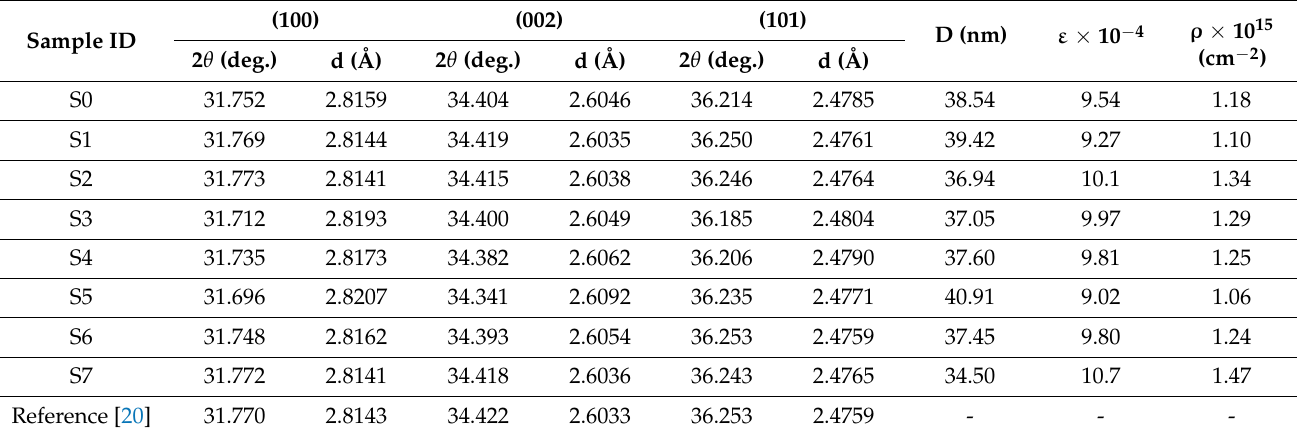
Table 1. Some structural parameters obtained and calculated from the films (D, average crystallite size; ε , micro-strain; ρ , dislocation density; d, distance between